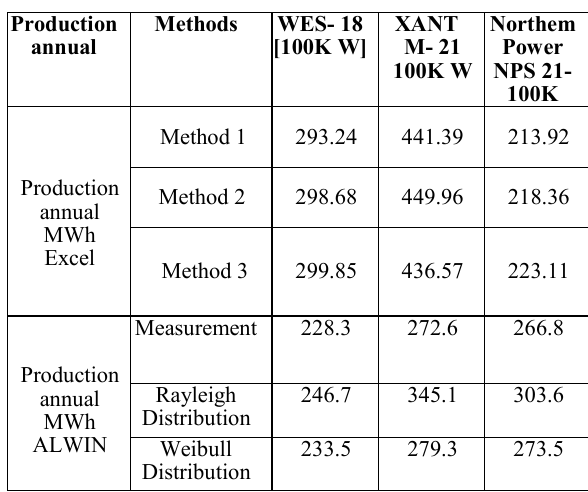
Table 9. Annual production of a single wind turbine for each technology.